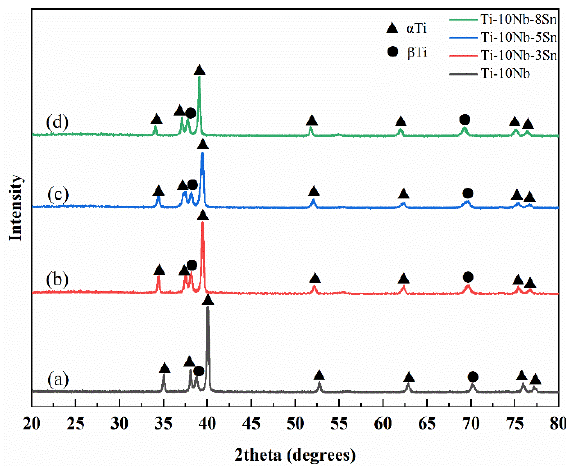
Figure 1. XRD patterns of PM-fabricated Ti-10N-xSn alloys: ( a ) Ti-10Nb, ( b ) Ti-10Nb-3Sn, ( c ) Ti-10Nb-5Sn, and ( d ) Ti-10Nb-8Sn.